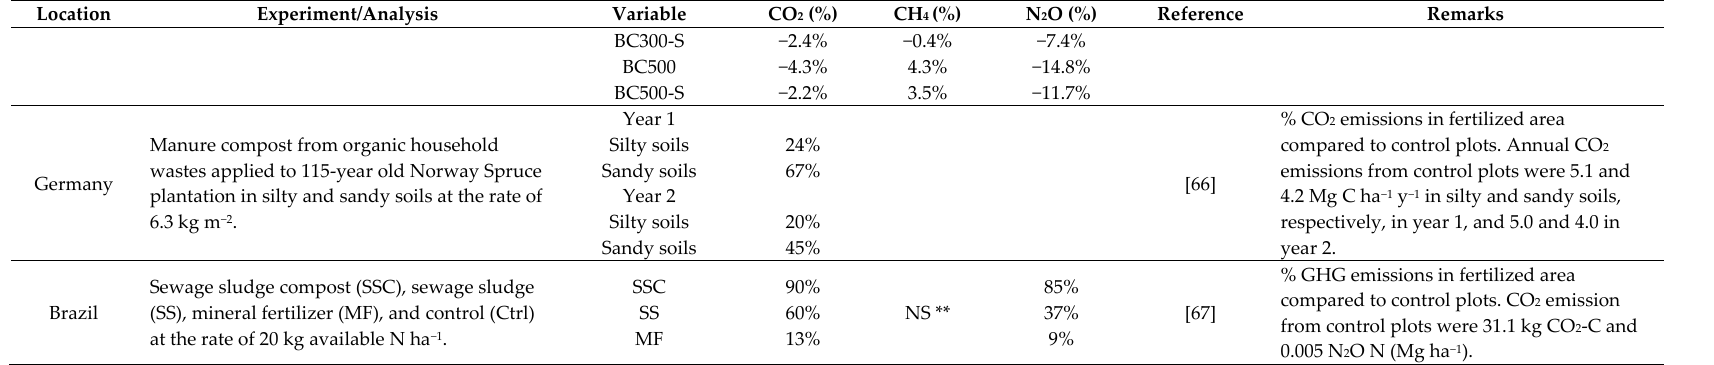
Table 2. Review of previous studies examining the effects of biochar and/or compost manure addition on relative changes in GHG emissions. Negative value shows